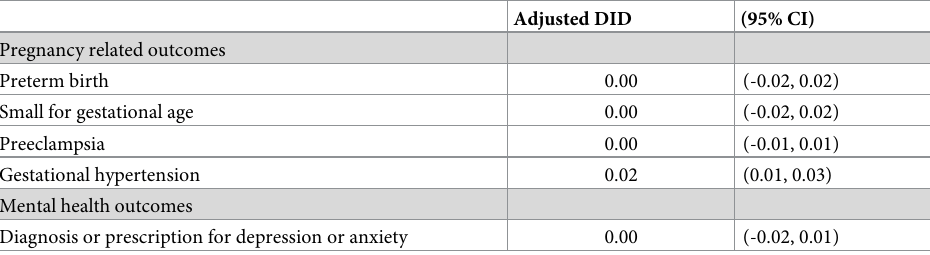
Table 2. Marginal effect of